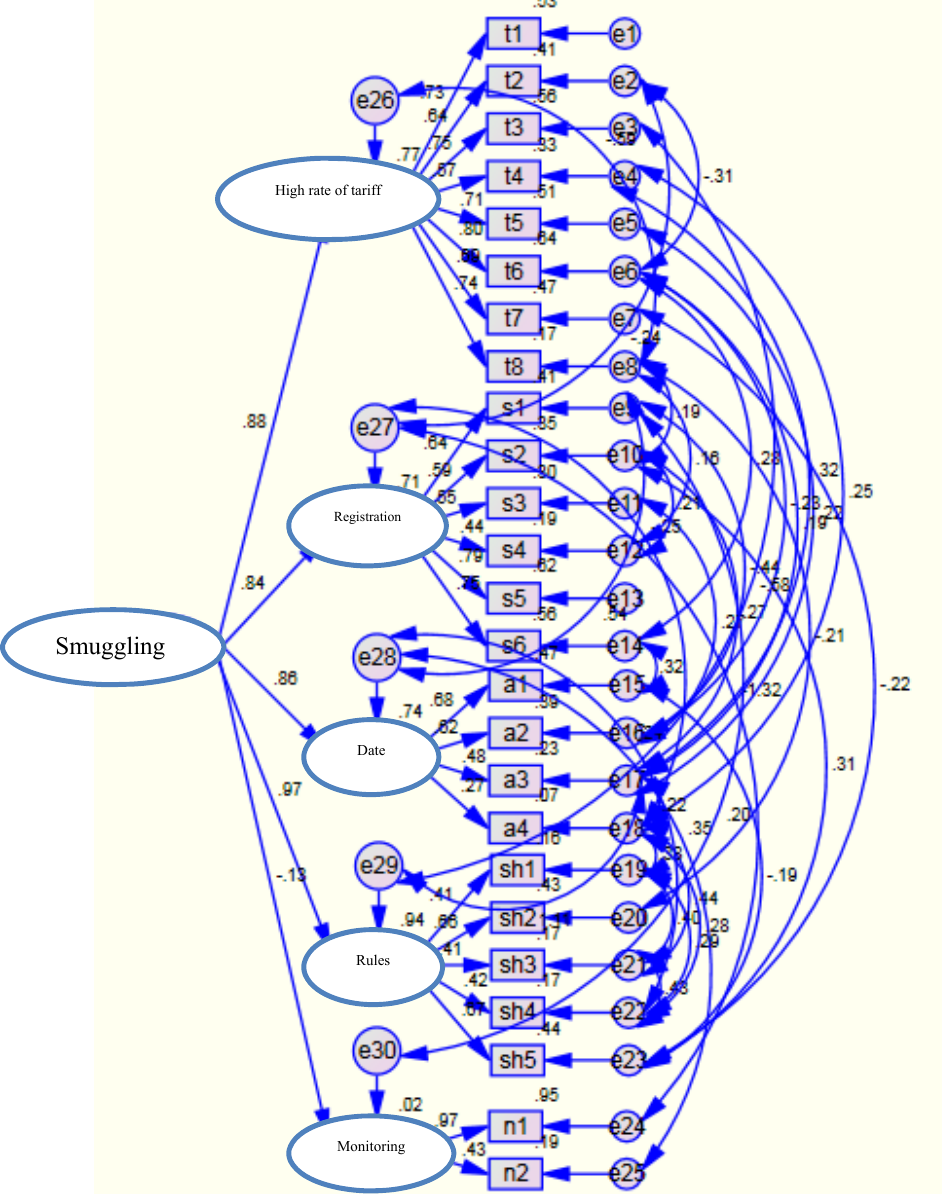
Fig. 2. The results of structural equation modeling in standard